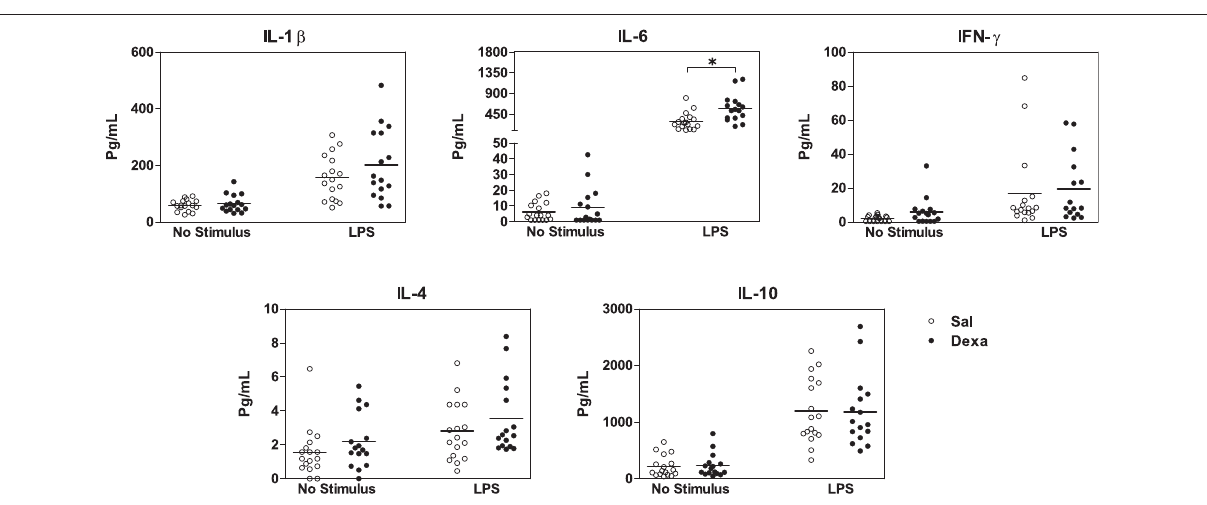
FIgure 5 | Splenocytes from Dexa rats produce increased levels of IL-6 after LPS stimulation. Spleen cells from Sal and Dexa rats were stimulated with LPS (5 μg/mL) during 48 h. Cytokine concentrations were determined by a multiplex cytokine assay in culture supernatants. Each point represents one rat and the line corresponds to the mean of 12–13 rats per group from two independent